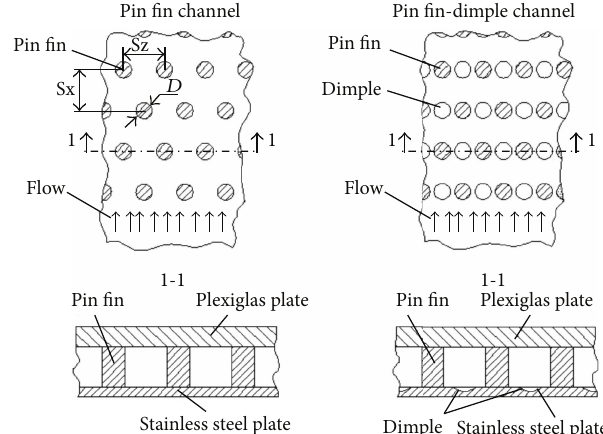
Figure 12: Pin fin and pin fin-dimple channel configurations considered within the channel flow investigation by Rao et al.